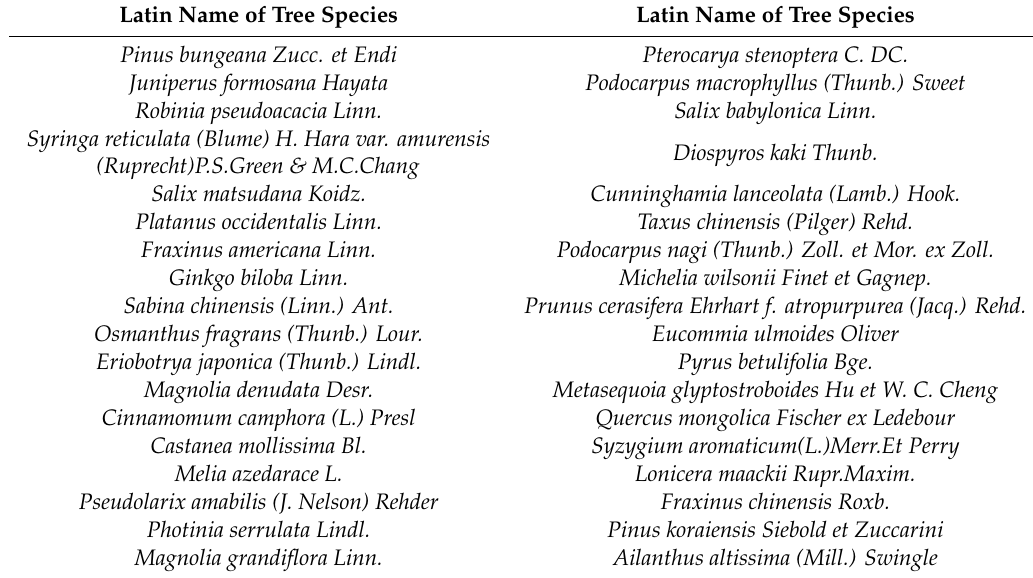
Table A1. Species of observation